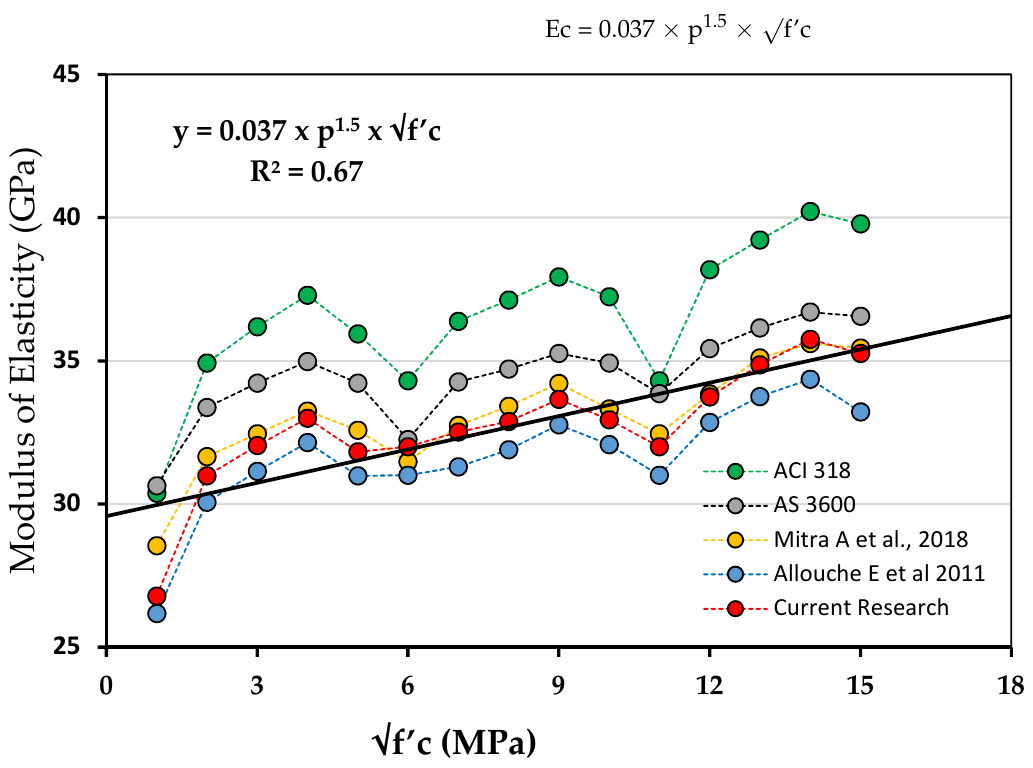
Figure 8. Projected relationship for the M.O.E. of graphene oxide G.P.C. Table 4. Values of projected M.O.E. from past studies, codes, and current research.